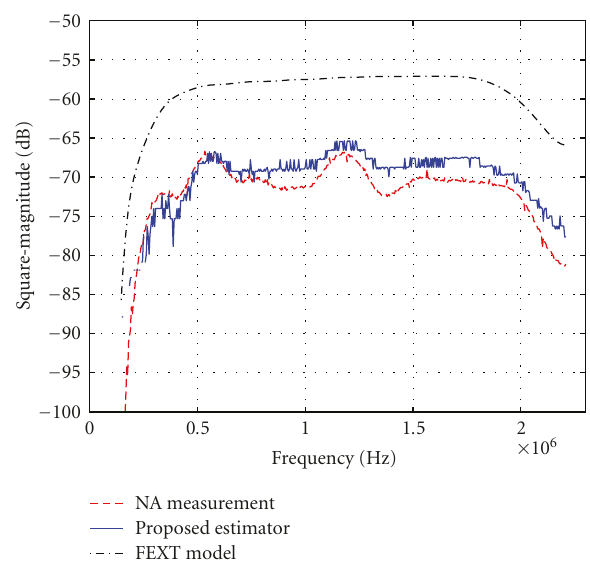
Figure 11: Square-magnitude of the upper FEXT channel in access network scenario I obtained with the NA, the FEXT model, and the proposed estimator.